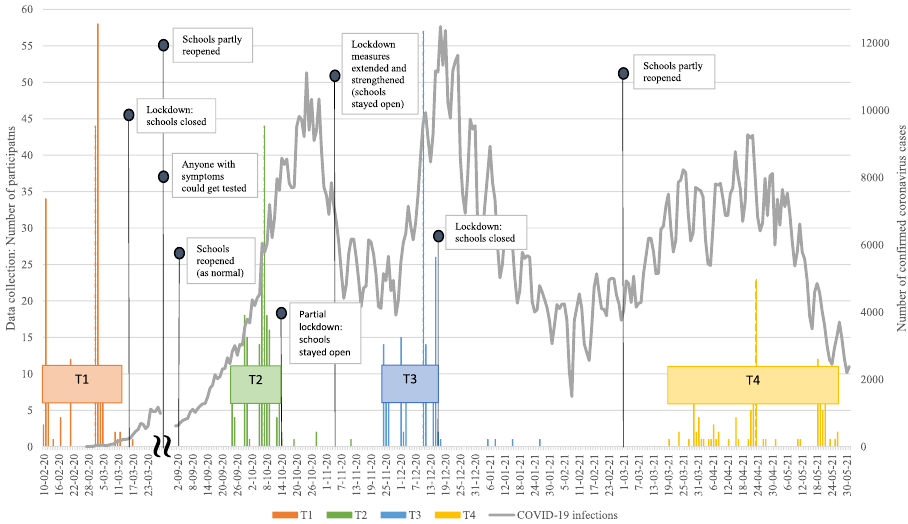
Figure 1. Overview of the data collection windows, the number of confirmed coronavirus cases and the government restrictions in the Netherlands. Note. The histograms present the number of assessed participants per timepoint, for each data collection window (T1: orange, T2: green, T3: blue, and T4: yellow). The dashed lines show the median of the data collection window. The line represents the number of confirmed coronavirus infections per day (adapted from the National Institute for Public Health and the Environment [RIVM]) 49 . From June 1, 2020, everyone with coronavirus-symptoms could get tested. Specific government restrictions regarding secondary schools are represented in text (adapted from the RIVM) 43